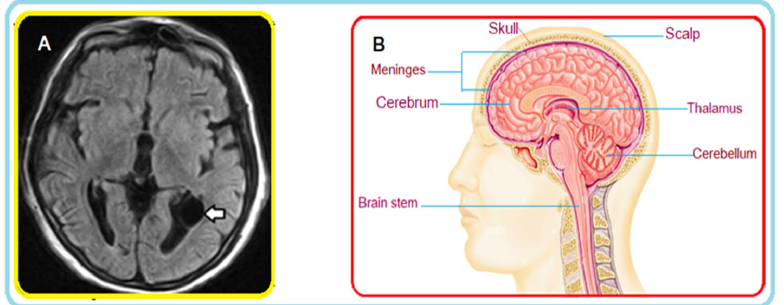
Figure 1. ( A ) MRI of the brain: axial FLAIR section. A thin ‐ walled cyst ‐ like image (arrow) consistent with an ependymal cyst can be seen in the occipital extension of the left lateral ventricle. ( B ) Brain cross ‐ section